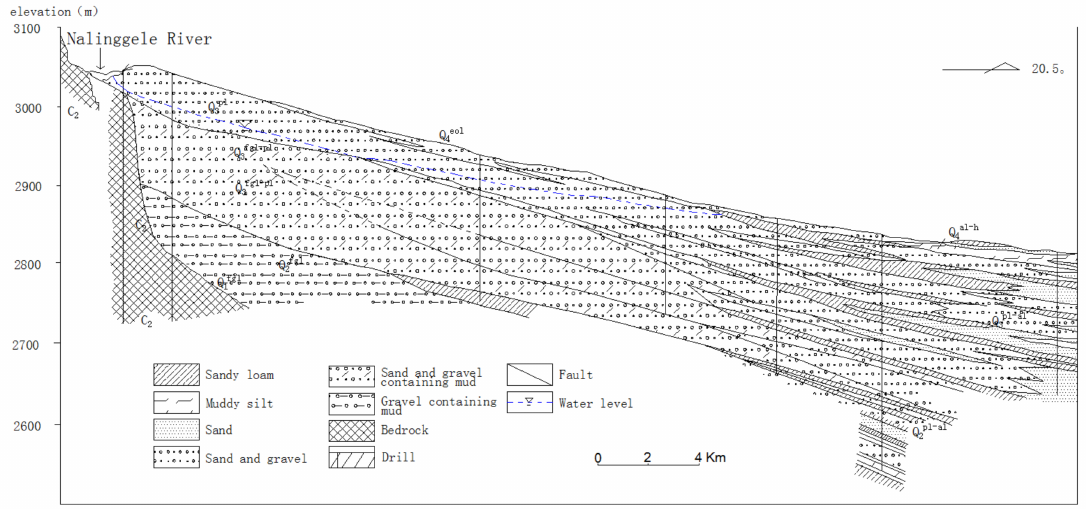
Figure 3. Sketch map of hydrogeological profile of alluvial fan in the Nalinggele